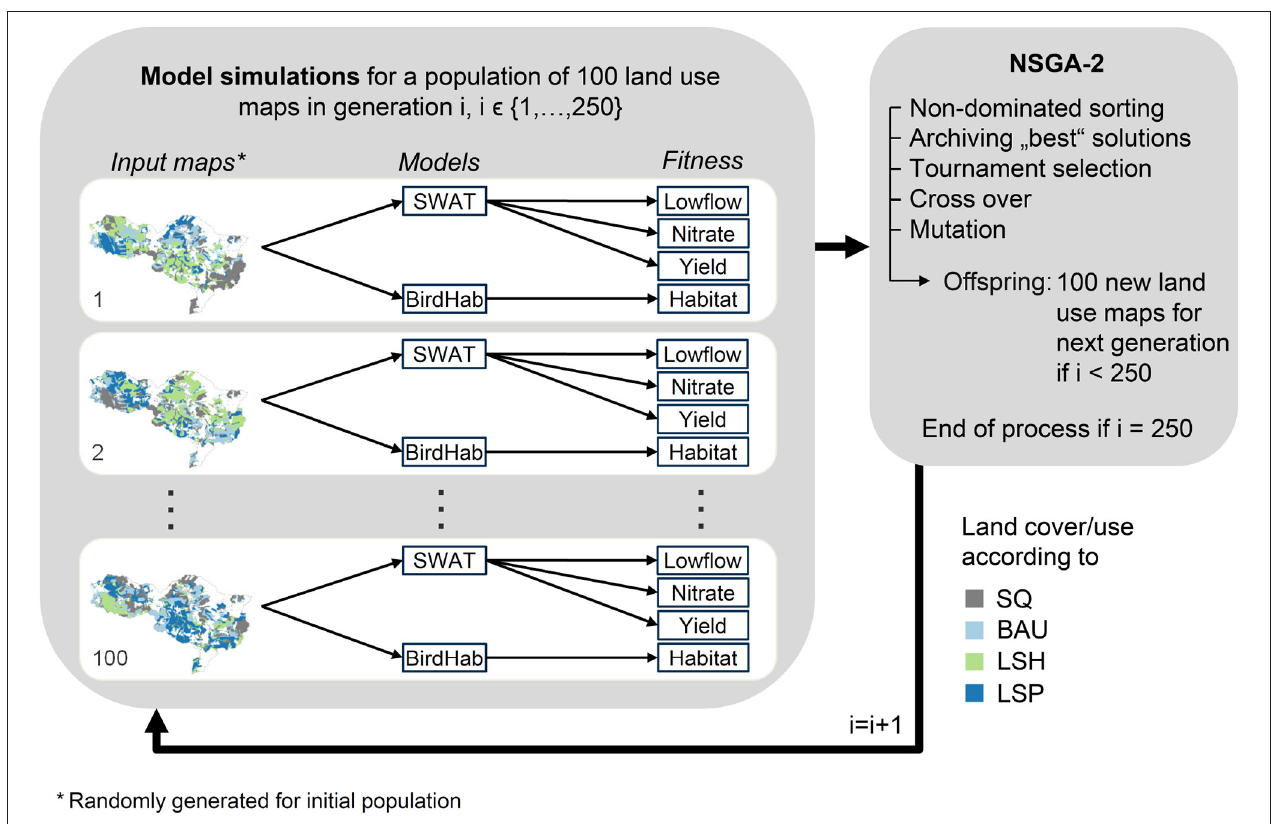
FIGURE 3 | Simplified workflow of the optimization process. CoMOLA starts an evolutionary process by first creating a set of different randomly generated land use maps ( n = 100). As the algorithm is inspired by biological evolution, its terminology and principles are likewise: each land use map is called an individual and is represented by a genome, i.e., a string of integers encoding the land use of each Hydrological Response Unit (HRU). Land cover and land use in an HRU can either be represented by scenario SQ (status quo), BAU (business as usual), LSH (land sharing), or LSP (land sparing). All maps of one generation form a population which changes over generations due to selection and variation (i.e., crossover and mutation). Using the Soil and Water Assessment Tool (SWAT) and a Random Forest bird species distribution model (BirdHab), each individual is assigned fitness values representing the achieved values for the four objectives. The genetic algorithm then applies a Pareto ranking for each individual based on its fitness. It archives best individuals and selects individuals for mating to generate a new (offspring) population. In mating, each offspring individual is generated by a random combination (crossover) of two genomes. The likelihood of mating increases for individuals with a higher Pareto rank. Additional random mutations increase the diversity of genomes to consider a wide range of different spatial configurations. The entire procedure, from fitness value calculation to offspring generation, is repeated for 250